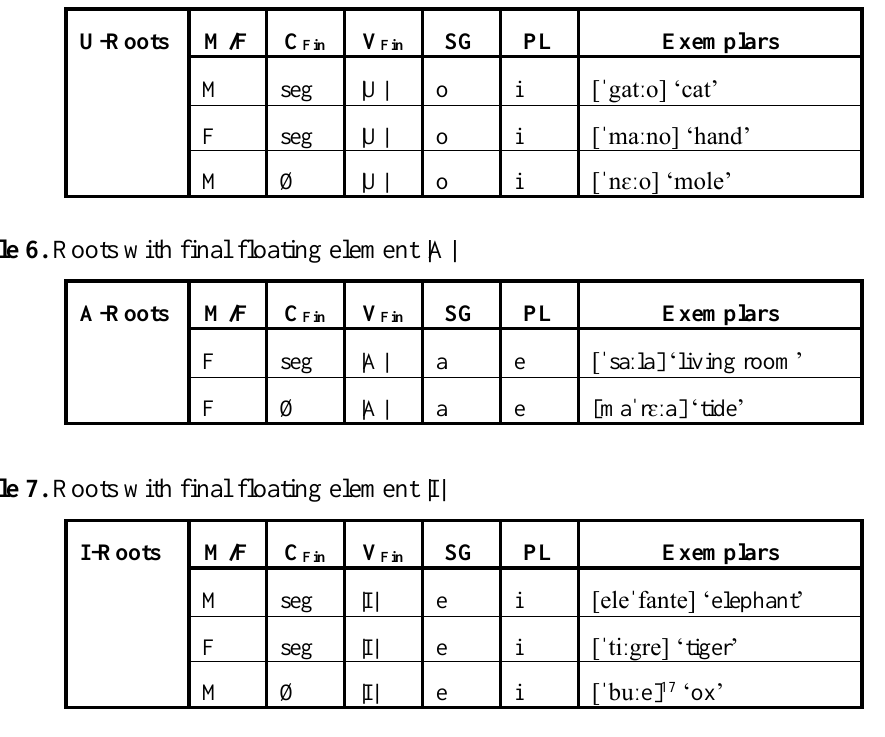
Table 5. Roots with final floating element |U|